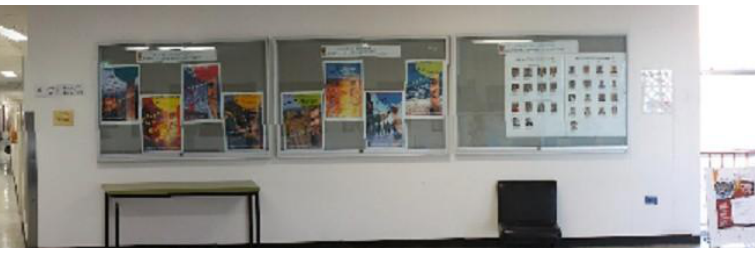
Figure 3. Panorama view of the mapped area in Figure